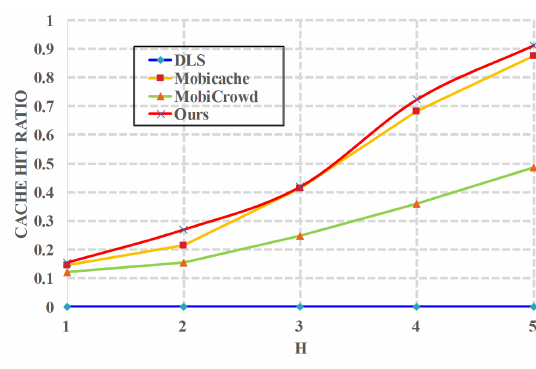
Figure 8. Cache Hit Ratio vs. h